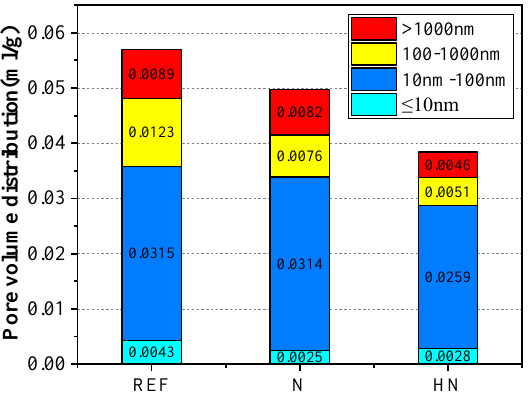
Figure 10. Pore volumes of different samples at different diameters.